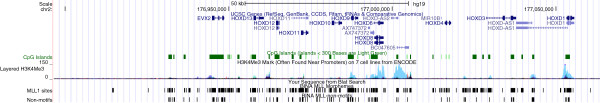
Localization of CGI and MLL1 morphemes in DNA segments encompassing human HOXD locus. Horizontal green bars mark the position of CGIs. Track-labeled “MLL1 sites” marks morpheme positions; “non-motifs” mark the position of sequences not found in results of SELEX assays [24]. Track-labeled “Layered H3K4me3” shows the position of H3K4me3 marks [59].